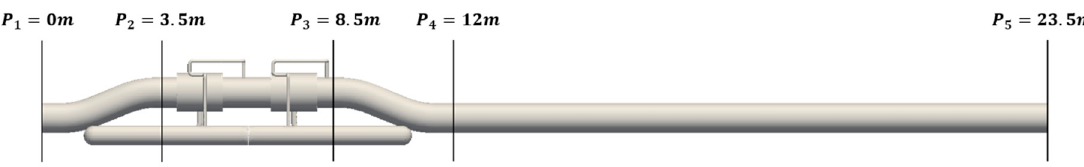
Figure 2. Computational grid at different regions of the mesh. (a) At the inlet, (b) at the swan neck, (c) in the vicinity of the first separator unit (second unit is identical).